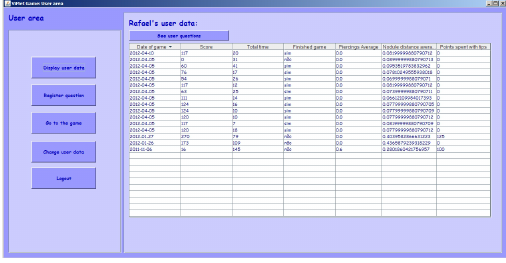
Figure 4. Automaton created to ViMeTGame storytelling.